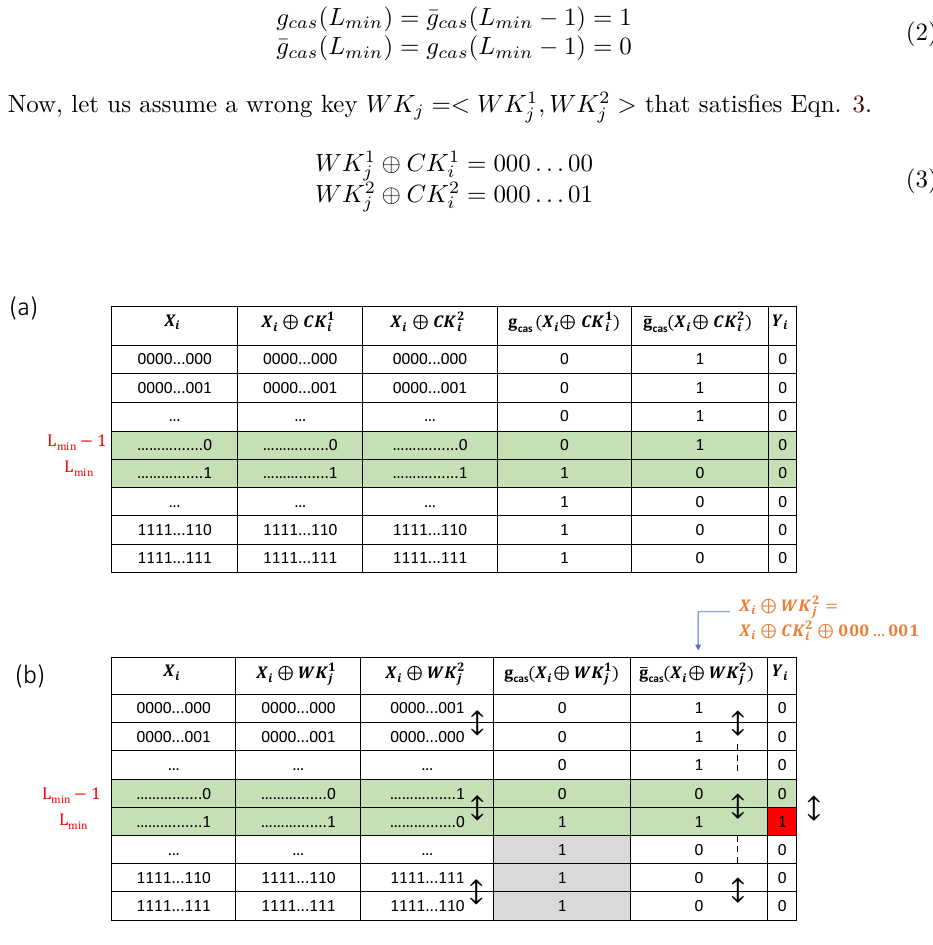
Figure 5: Example Truth Table for g cas and ¯ g cas , where the wrong key WK j can only be ruled out by applying the input pattern L min